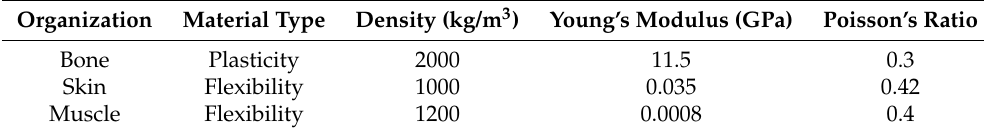
Table 2. Elastic tissue material